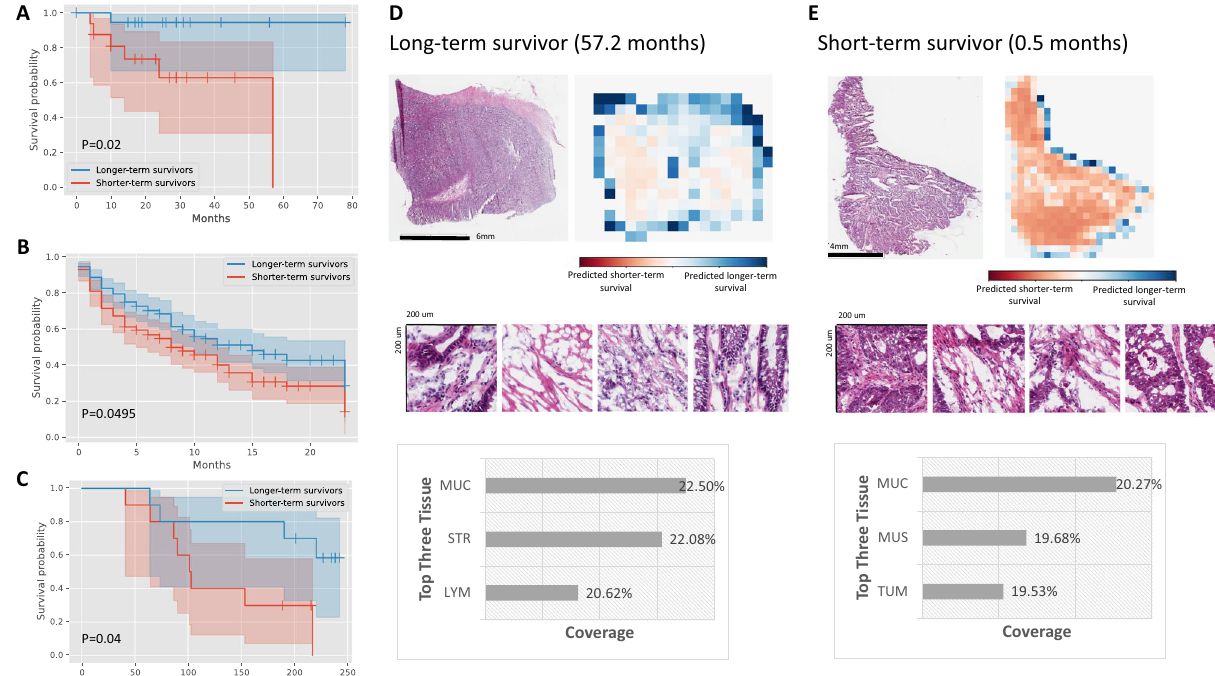
Fig. 4 | MOMA predicts overall survivaloutcomesofstage III colorectal cancer patients using digital histopathology images, with validation in multiple independent cohorts. A MOMA successfully distinguishes the shorter-term sur- vivorsfromlonger-termsurvivorsusinghistopathologyimages(two-sidedlog-rank test P -value=0.02). Results from the TCGA held-out test set are shown. B The machine learning model derived from MOMA is successfully validated in an inde- pendent external validation set from the Nurses ’ Health Study and Health Profes- sionals Follow-up Study cohorts (two-sided log-rank test P -value<0.05). C We further validate our overall survival prediction model in PLCO,a nationwide